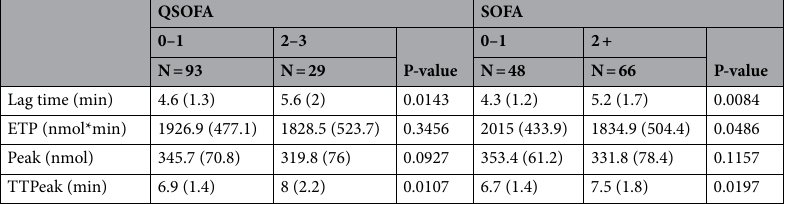
Table 2. Thrombin generation and qSOFA/SOFA scores. Variables are presented as the mean (SD). For continuous variables, the t-test was implemented. SOFA, sequential organ failure assessment. qSOFA quick sequential organ failure assessment, Min minute, ETP endogenous thrombin potential, TTPeak time to